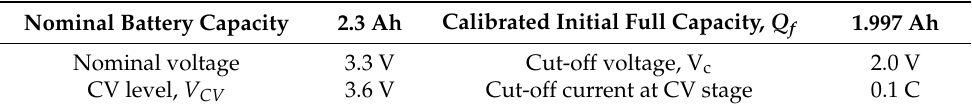
Table 1. Battery specifications.